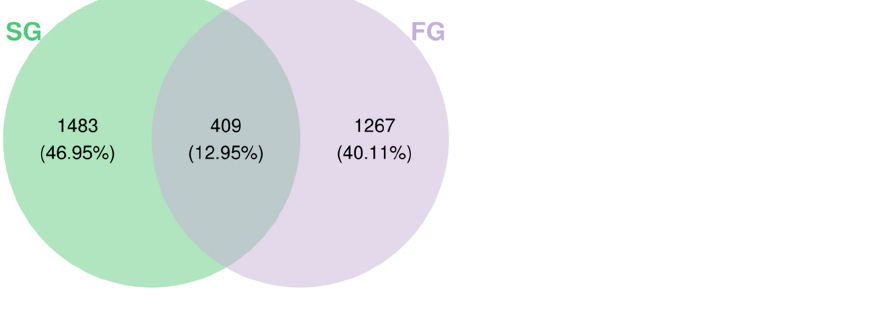
Figure 2. Venn diagram of the intestinal flora of the slow-growing (SG) and fast-growing (FG) groups of juvenile largemouth bass. Coverage was used to estimate the completeness of sequencing in the alpha diversity analysis. The community coverage for each sample exceeded 99.93%, indicating that the probability of a collection sample not being sequenced was low. The coverage, Shannon index, Simpson index and Chao1 values for each sample from both groups of fish are shown in Figure 3 and were not significantly different between groups ( p ≥ 0.05).